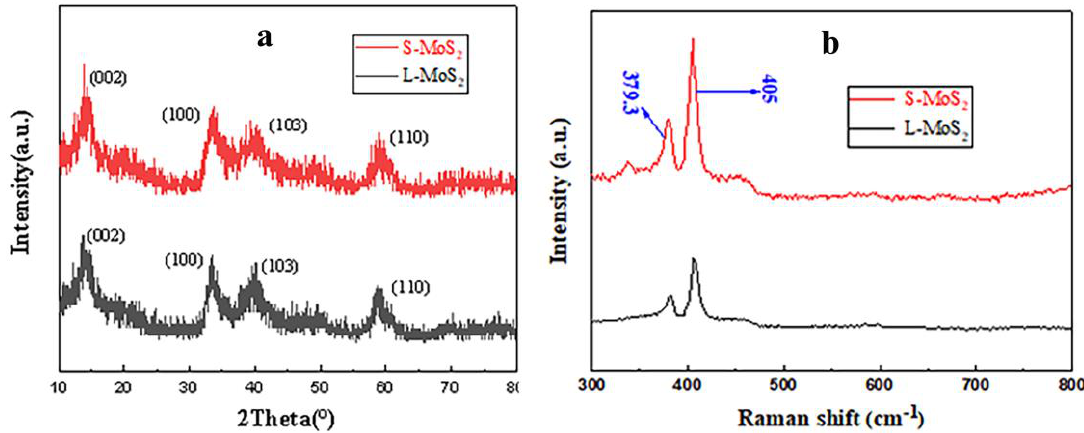
Figure 3. XRD ( a ) and Raman ( b ) spectra of the S - MoS 2 and L - MoS 2 .